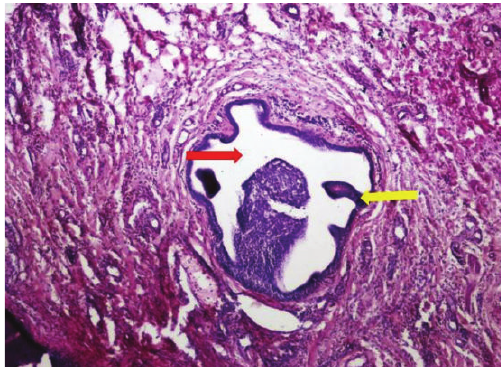
Figure 2: Histopathological section of H&E specimen (40x) show- ing minor salivary gland with atrophy of the acinar cells (red arrow) and with large dilated duct is partly double walled and partly stratified squamous with numerous papillary fronds (yellow arrow) extending into the lumen.